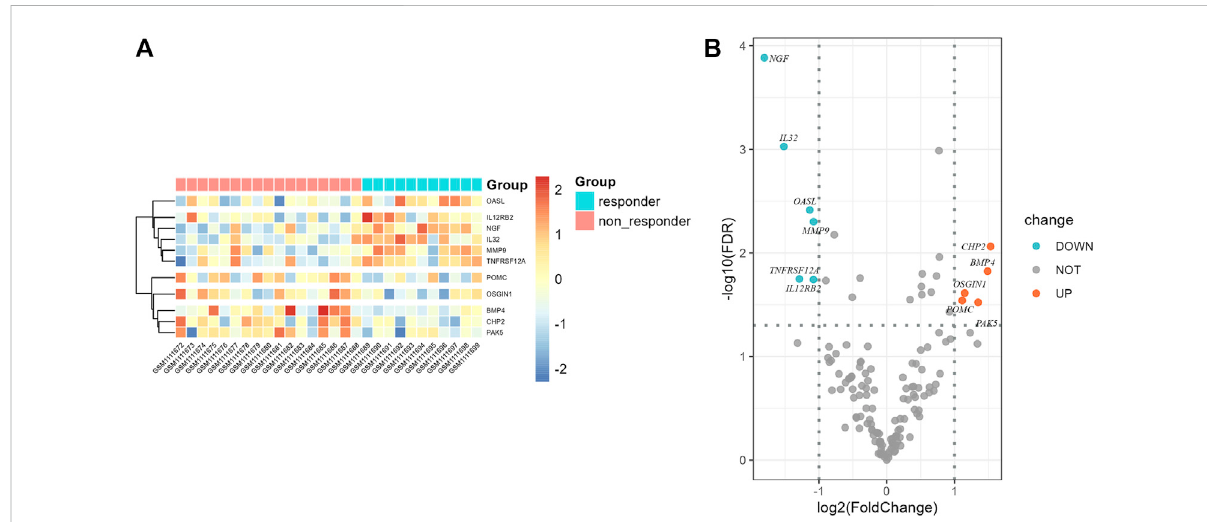
FIGURE 9 Differential expression results of immune genes in GSE45670 cohort. (A) Heatmap, (B) Volcano map.